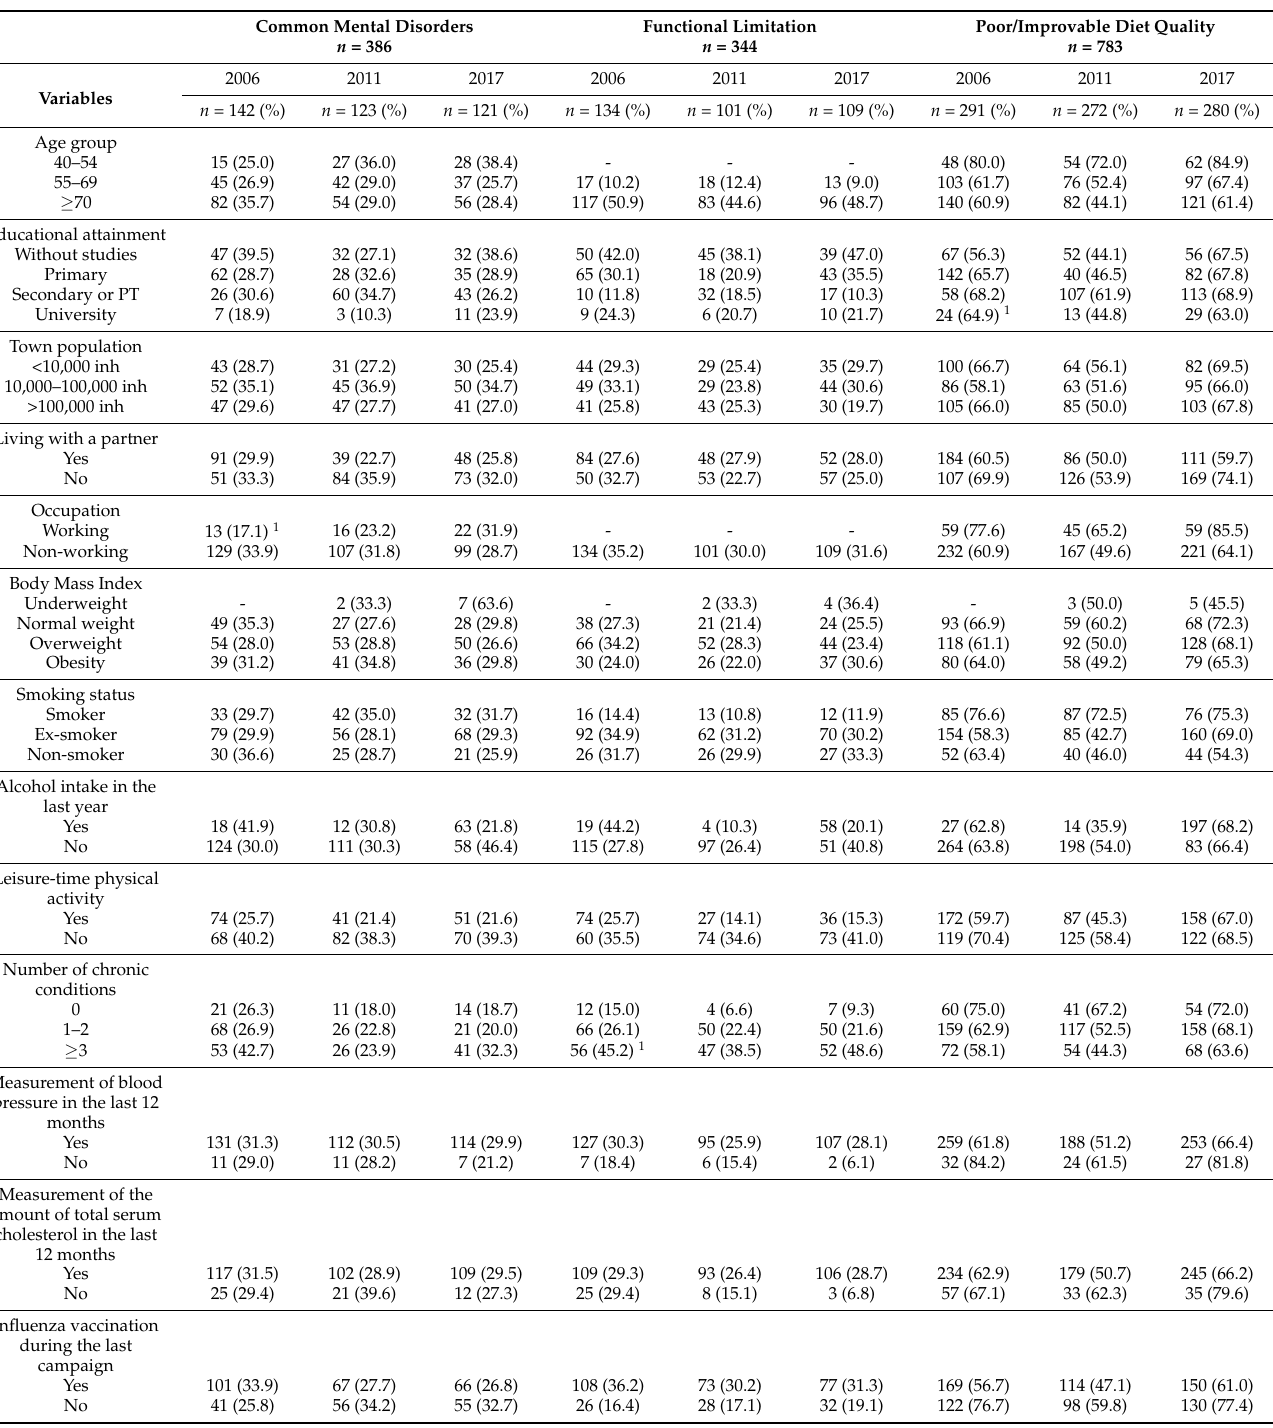
Table 2. Distribution of the CMDs, functional limitation and poor/improvable diet quality according to the study variables in men with COPD from 2006 to 2017 ( n =